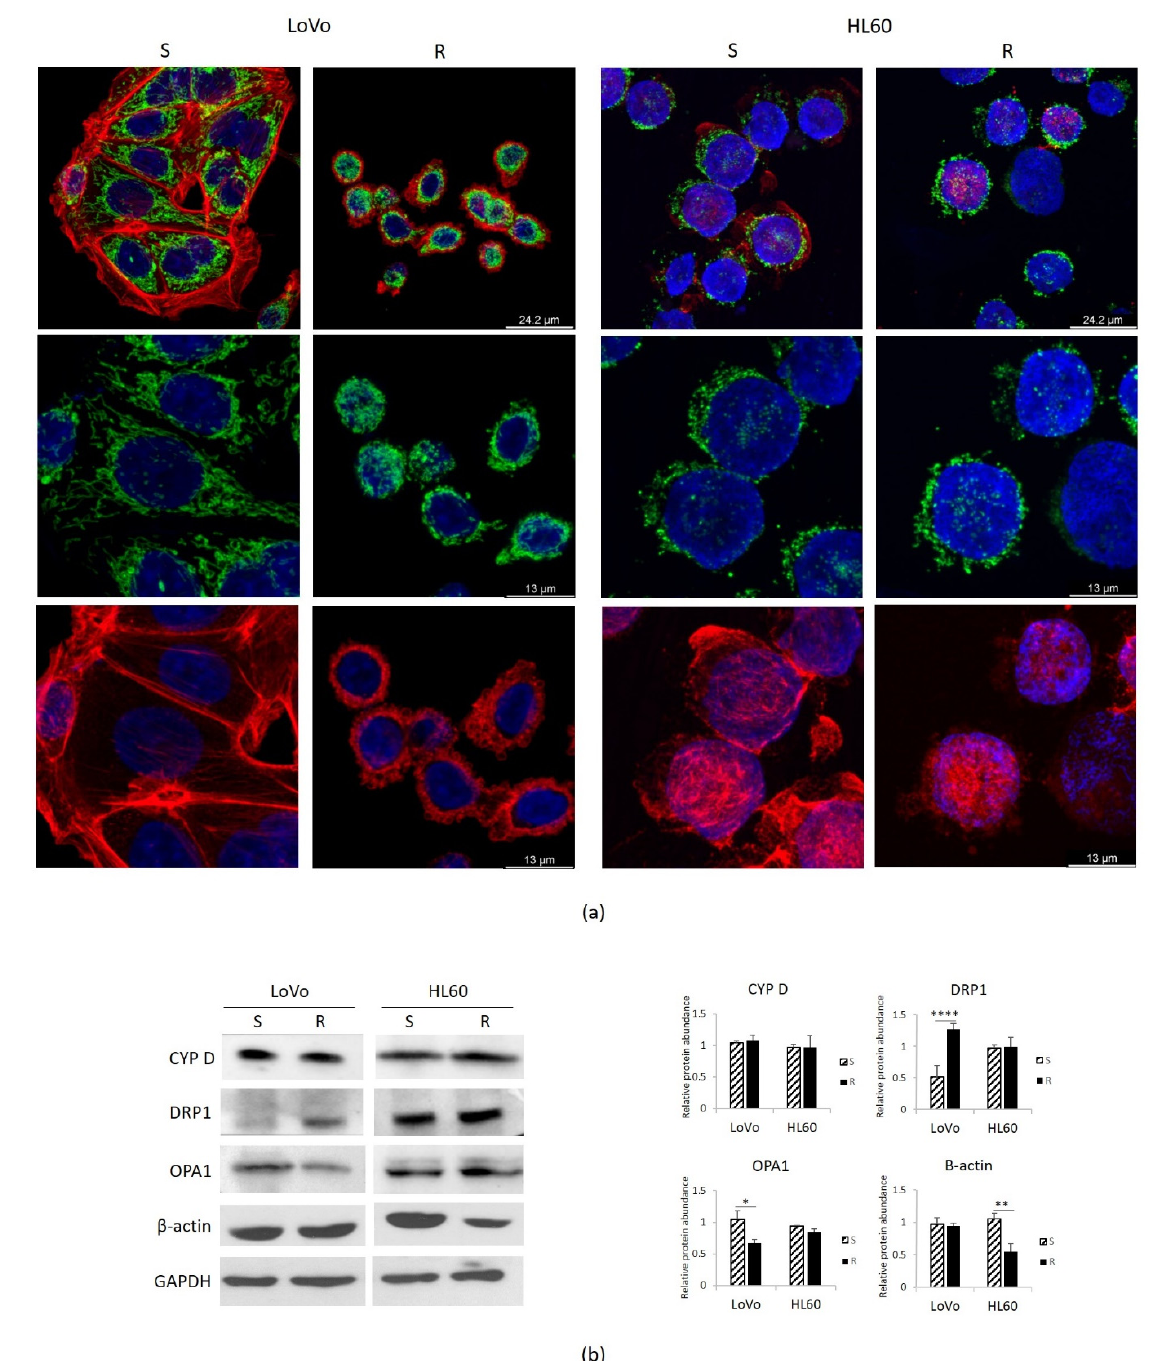
Figure 5. Mitochondria in DXR sensitive and resistant cells. LoVo and HL60 were cultured for 24 h in their culture medium. ( a ) LoVo were directly cultured on coverslip, while HL60 were cultured in flasks and then cytospun on glass coverslips. The cells were stained with CYP D to visualize the mitochondria (green), with rhodamine-conjugated phalloidin to visualize cytoskeleton (red) and DAPI to label the nuclei (blue). ( b ) Western blots were performed on protein lysates using antibodies against CYP D, DRP1, OPA1 and β -actin. GAPDH was used as control of loading. A representative blot and densitometry obtained by ImageJ are shown. * p < 0.05; ** p < 0.01; **** p < 0.0001.